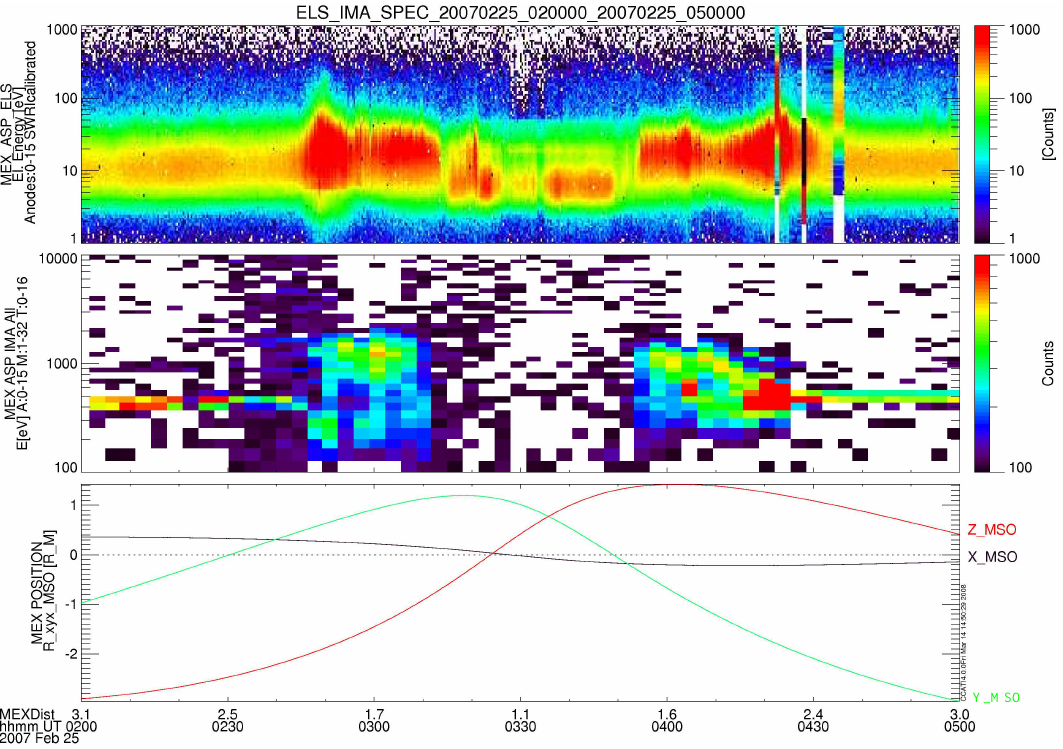
Fig. 6. Electron and ion spectra measured by ELS and IMA sensors onboard MEX/ASPERA-3 from 02:00UT (only two minutes after Rosetta’s closest approach) till 05:00UT. Additionally, the coordinates of the MEX orbit in MSO coordinates are given at the bottom panel. MEX enters the foreshock region, the bows shock, and the ICB/MPB at 02:45UT, 02:48UT, and 03:14UT, respectively. At the ICB/MPB location the intensity in the ion spectrum falls sharply over the whole energy range. IMA could only measure solar wind protons and He ions. The ionopause is crossed at 03:22UT, afterwards low energetic electrons at around 5eV and atmospheric photoelectrons at around 20eV are measured. During the outbound path data gaps in ELS occur. See Fig. 8 for the from the spectra derived